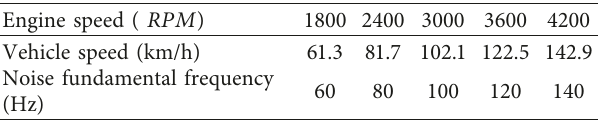
Figure 10. The convergence effect of the error signal is simulated by using the improved algorithm and the refer- ence signal in Figure 10.